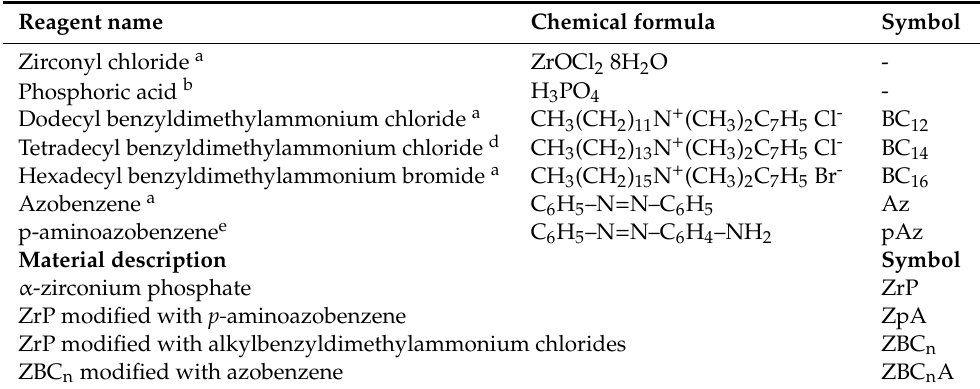
Table 1. Reagents and samples description and